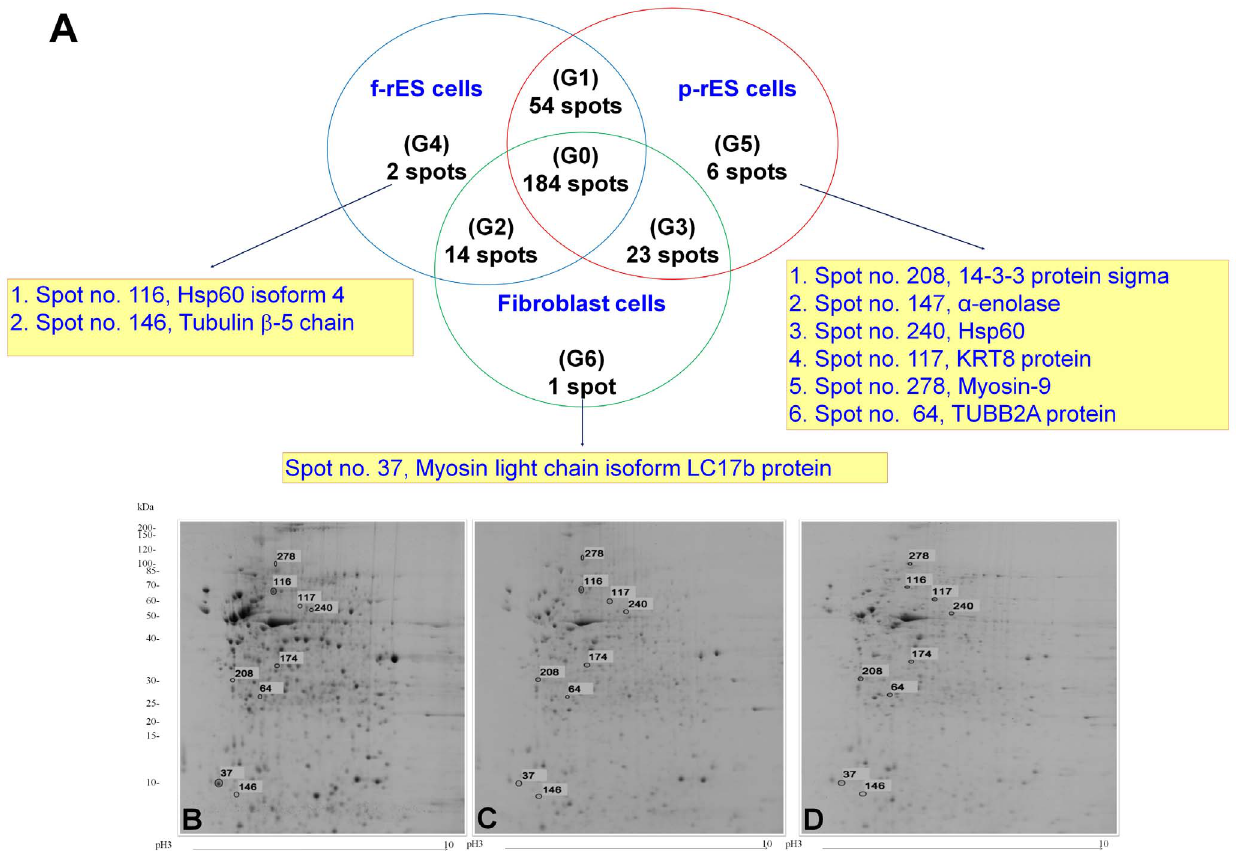
Figure 6. Distributions and classifications of protein expression profiles in rabbit fibroblast, f-rES, and p-rES cells. (A) The 284 quantified protein spots in the three cell types were mandatorily classified into seven groups (G0-G6) based on the similarities or differences in protein expression levels. (B) A representative 2-DE gel (fibroblasts) showing the protein spot (No. 37; G6) exclusively expressed in fibroblast cells. (C) A representative 2-DE gel (f-rES cells) showing the two protein spots (No. 116 and No.146; G4) exclusively expressed in the f-rES cells. (D) A representative 2-DE gel (p-rES cells) shows the six proteins (No. 64, 117, 174, 208, 240, and 278; G5) that are exclusively expressed in p-rES cells. The numbers are the spot numbers in Table 4.